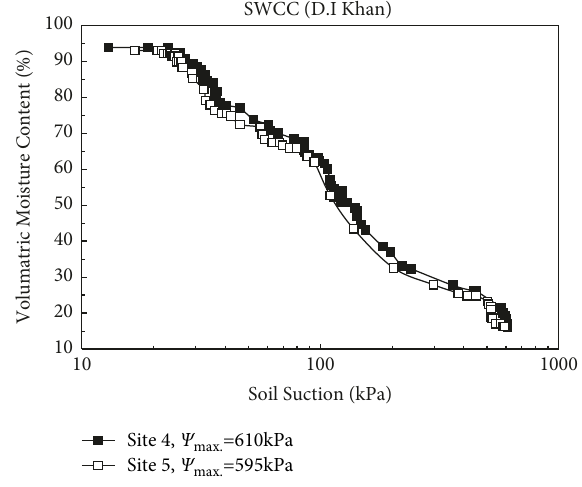
Figure 4: Demonstration of field-based SWCCs for sites S in D.I Khan Expansive